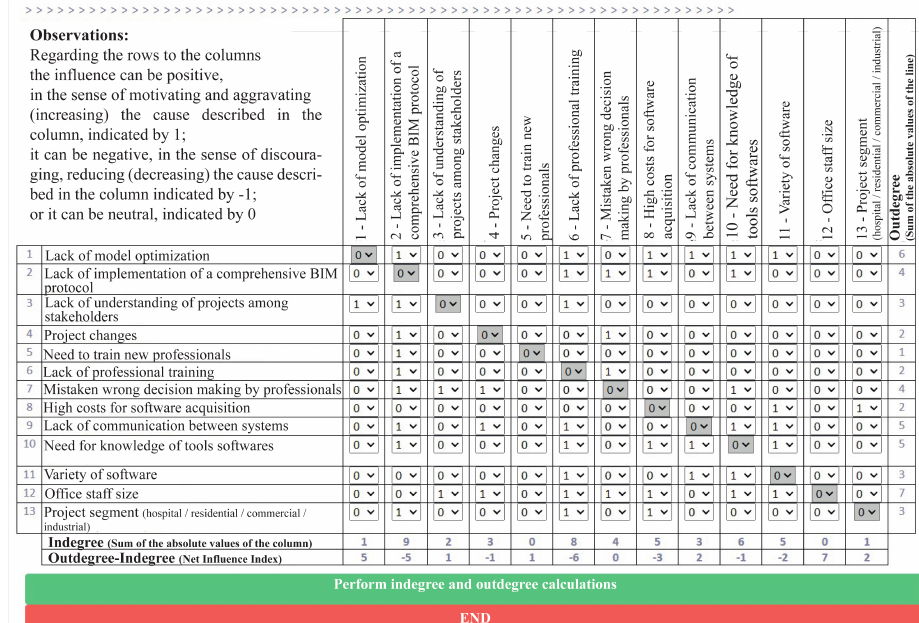
Figure 11. Causal loop